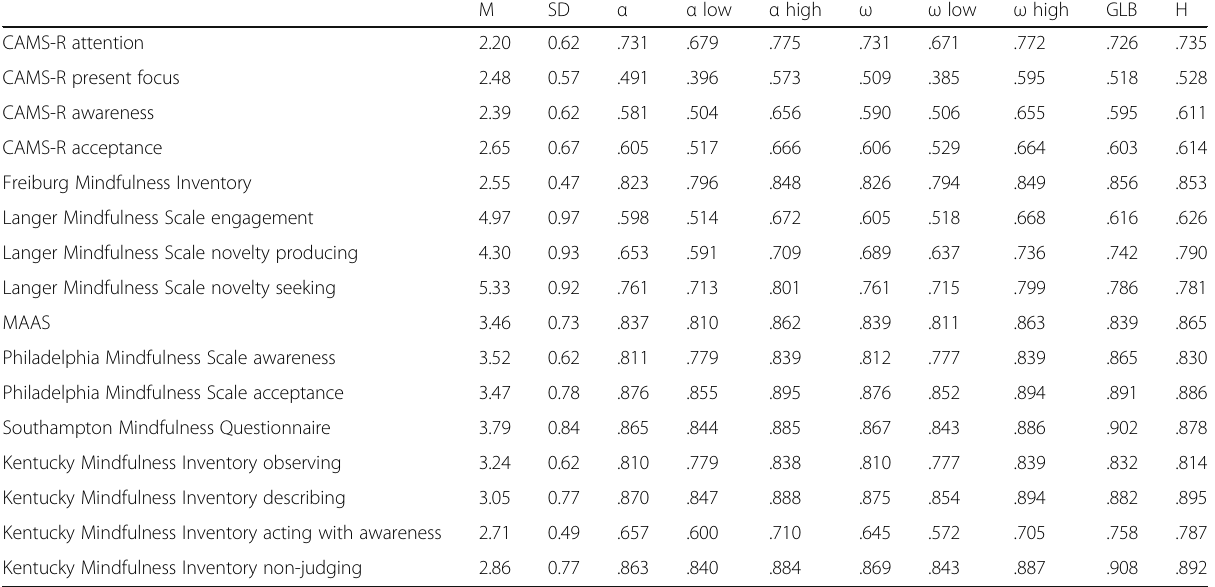
M SD α α low α high ω ω low ω high